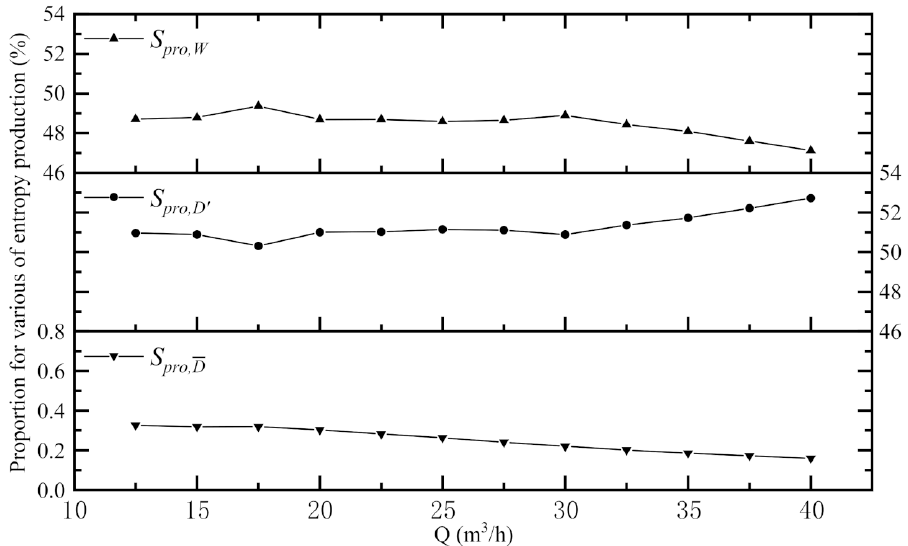
Figure 9. Different dissipation components versus the flow rate